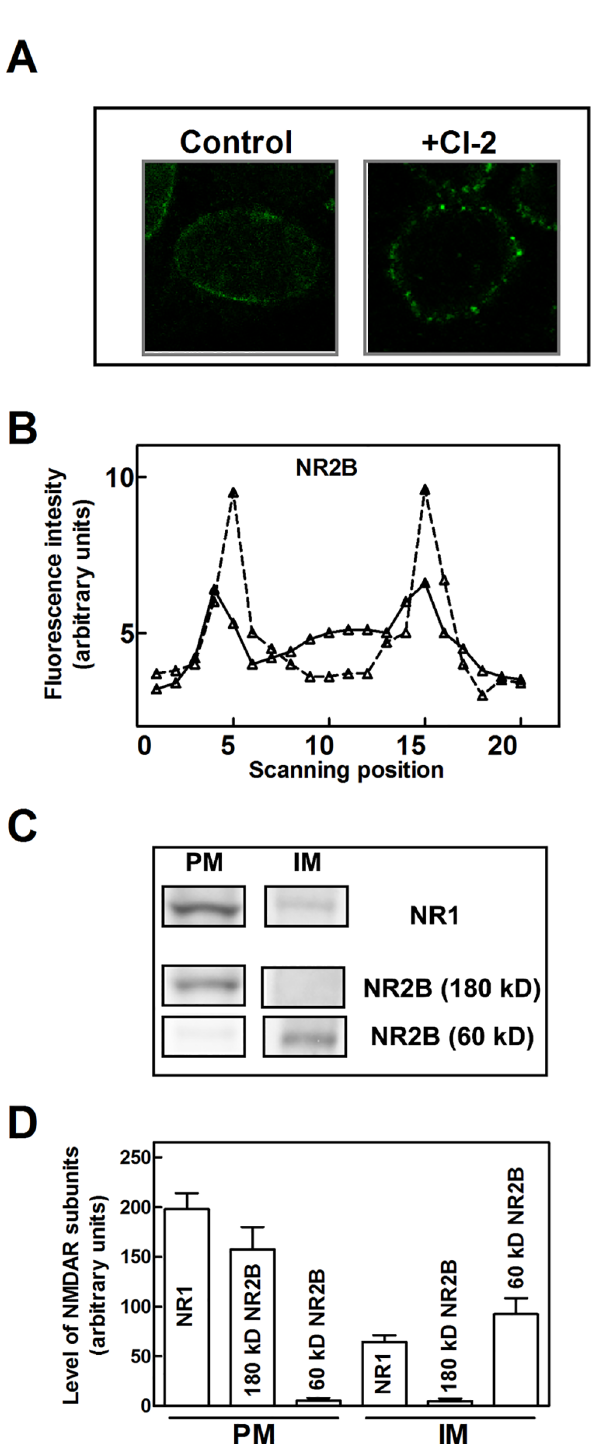
Fig 4. Effect of calpain inhibition on intracellular localization of NMDAR. (A and B) SKNBE cells untreated (Control, solid line) or treated with 1 μ M CI-2 (+CI-2, dashed line) for 24 hours were fixed and NR2B localization was determined by confocal microscopy (see Methods). NR2B signal (green fluorescence) was continuously monitored during cell scanning by using Laser Pix software, as previously reported [54]. Each scanning trail is representative of 20 cells analyzed. (C) Aliquots (100 μ L) of cell membranes were collected from the two fractions layered at 10% and 30% sucrose interface (see Methods) and assayed for 5 0 - nucleotidase activity, in order to determine the fraction containing the plasma membranes (PM) and the